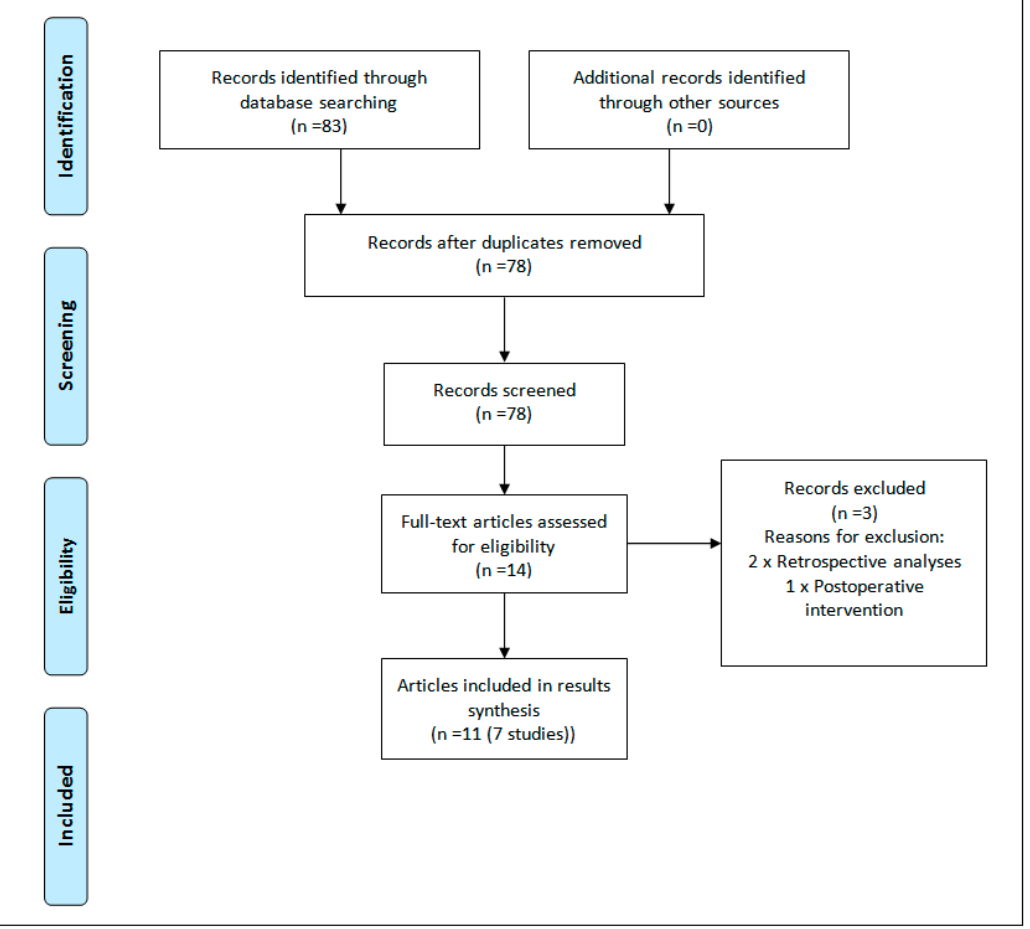
Figure 1. Preferred Reporting Items for Systematic Reviews and Meta-Analyses (PRISMA) flowchart [13].